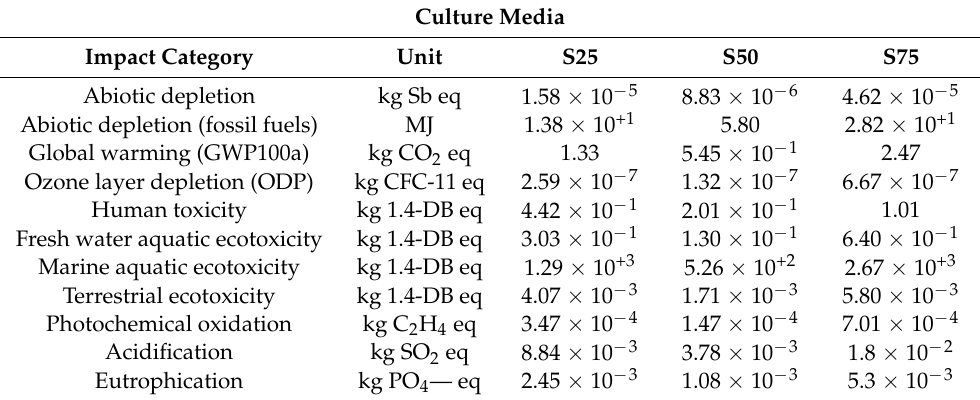
Table 5. Comparison of the life cycle impact of 1 kg of lemons for the three substrate alternatives, with different proportions of port